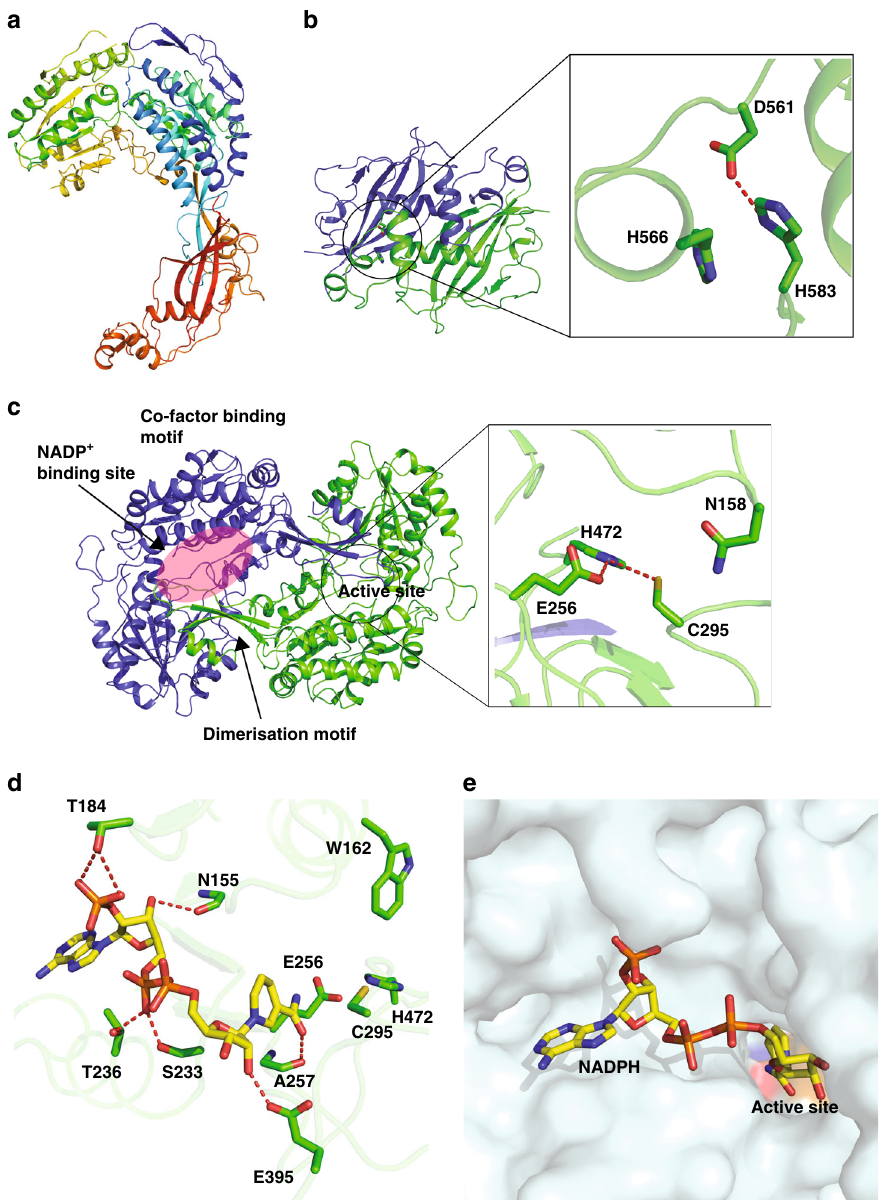
Fig. 3 Enzymatic domains in PaaZ and the cofactor binding site. a The polypeptide of the PaaZ monomer color coded in rainbow with the N-terminus in blue and C-terminus in red. b The hydratase domain is made of fi ve β -sheets with three additional helices and the monomers are colored in blue and green. The active site comprising D561 and H566 of one monomer is closer to the substrate-binding tunnel of the other monomer, and a hydrogen bond (3.3 Å) is observed between H583 and D561. c The dehydrogenase domain can be divided into three sub-domains: co-factor binding, catalytic and dimerization 23 . They are made of a mixture of α -helices and β -strands. The active site of the dehydrogenase domain consists of nucleophile cysteine C295 and E256. A histidine residue (H472) is in hydrogen bonding distance to E256 and ~3.55 Å to C295. The distance between E256 and C295 is 3.5 Å. The monomers of the dehydrogenase domain are colored in blue and green. d The interactions of NADPH observed in the structure. Numerous interactions with polar and charged residues of the enzyme stabilize the NADPH binding. e The NADPH binding groove and the active site residues are colored (C295 in orange, E256 in red and H472 in blue). The nicotinamide moiety points towards the active site